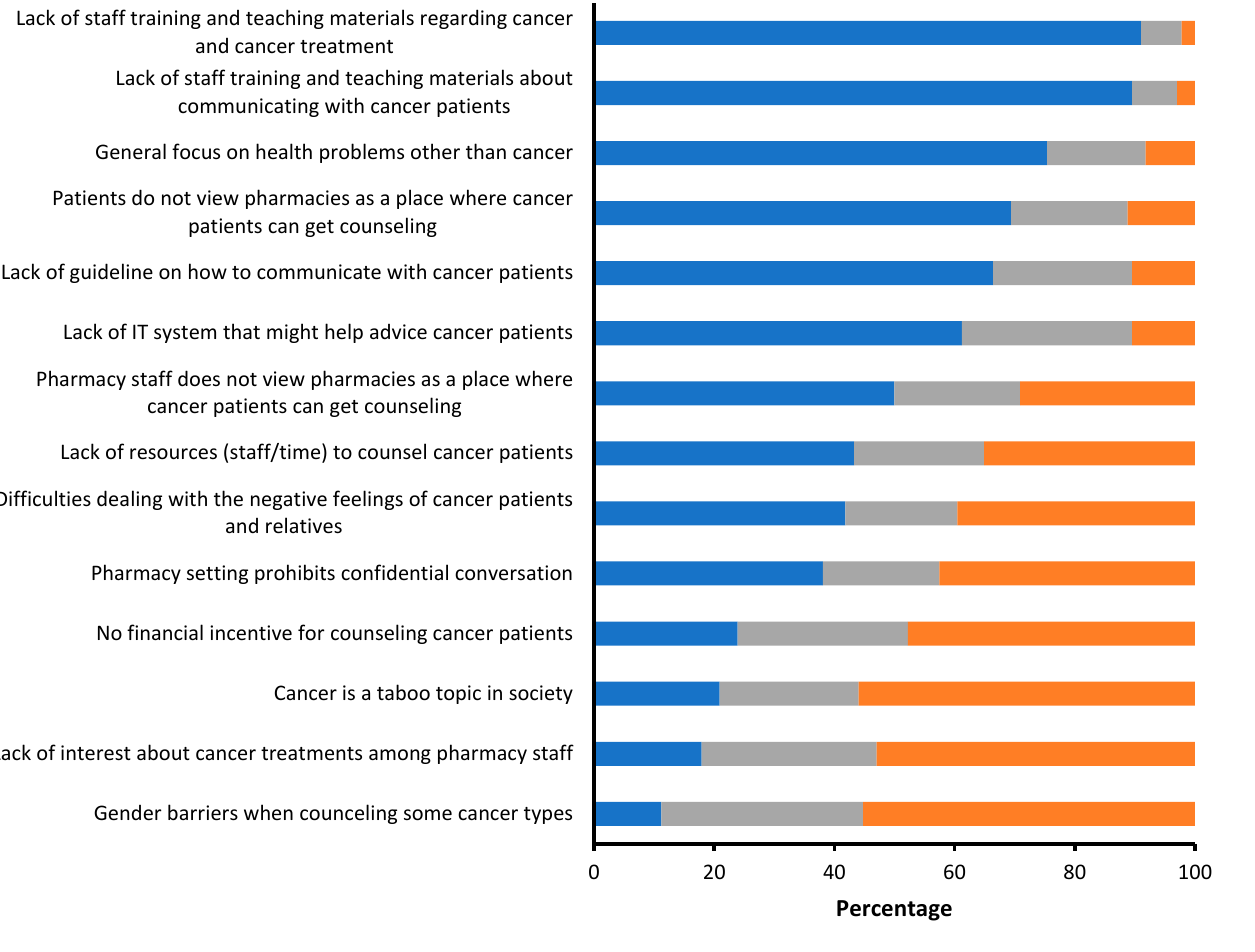
Figure 1. Potential barriers concerning counseling current or former cancer patients at a community pharmacy. Ratings are defined as: Agree and strongly agree. Neutral. Disagree and strongly disagree. (n = 134).